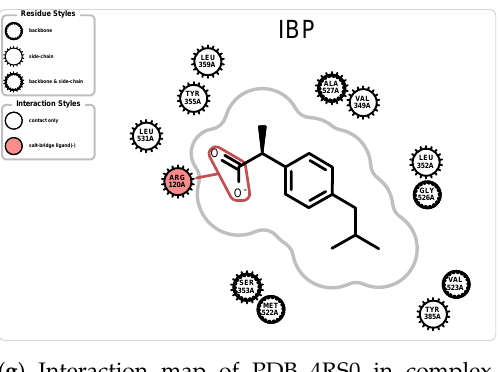
Figure 13. Ibuprofen (IBP) schematic and sample interaction map, and box plots for SingleCut metrics for 5 protein-IBP complexes. † and ‡ identify atoms involved in hydrogen bond and hydrophobic interactions,